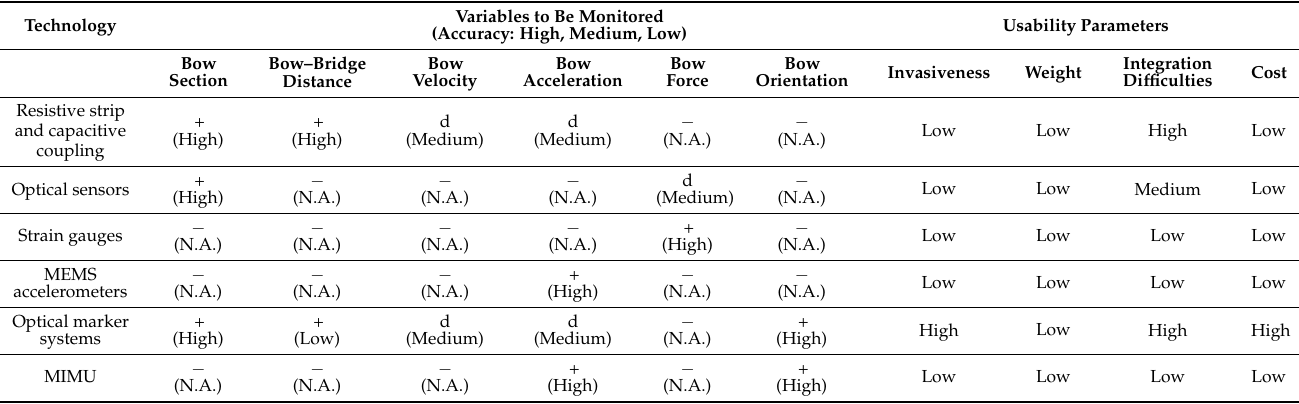
Table 1. The technology comparison table lists different technologies used to monitor bowing and provides information about the variables they monitor and the